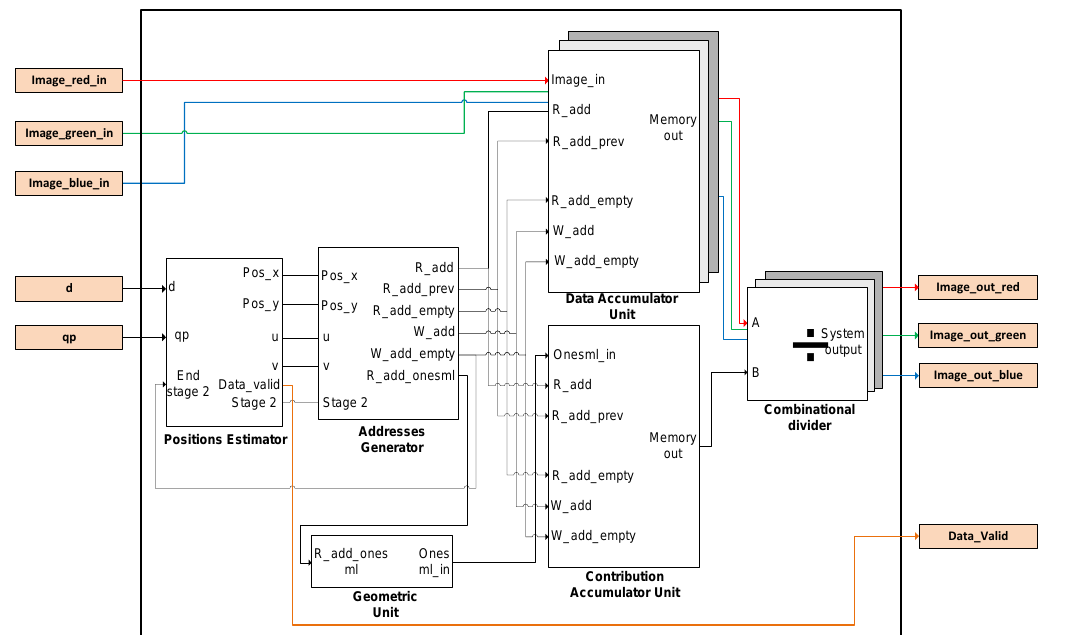
Figure 3. Architecture of the designed